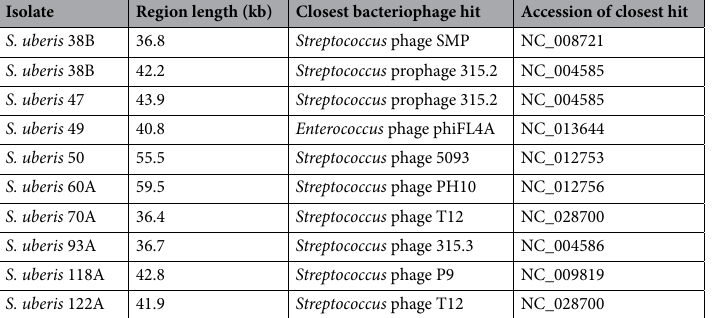
Table 4. Table of putatively intact bacteriophage presence within the S. uberis isolates identified in this study. The closest-related phage are also shown, along with the accession numbers.